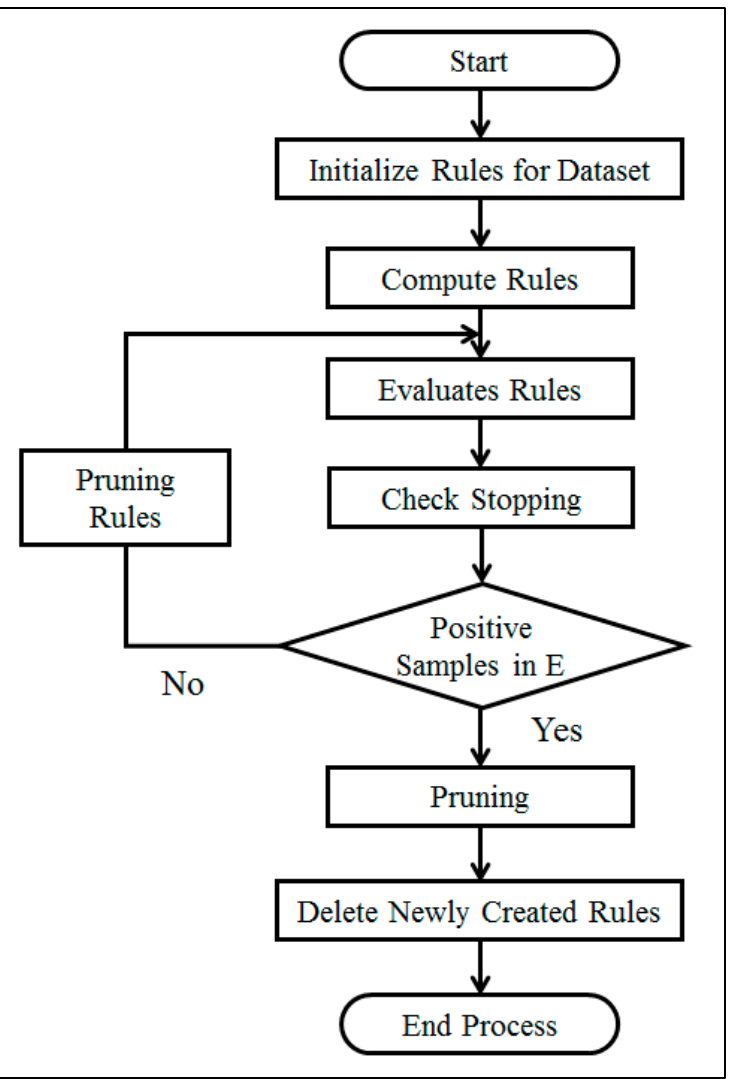
Figure 2. FURIA algorithm flowchart [22].